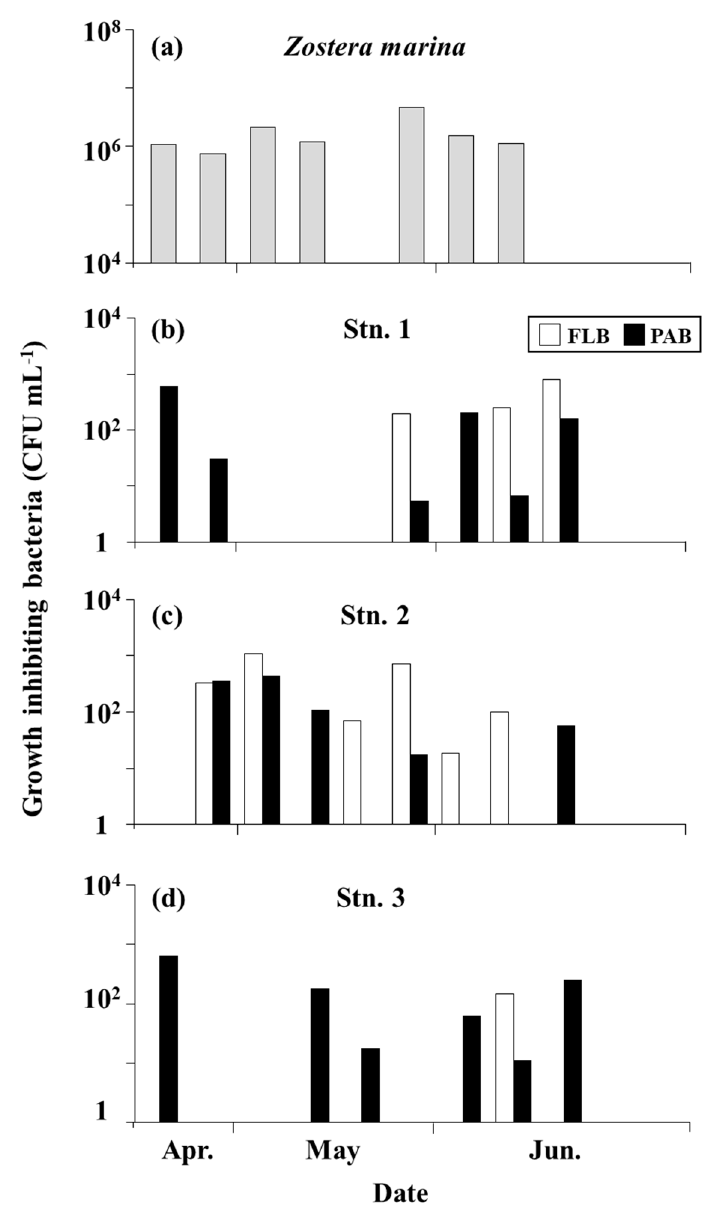
Figure 10. Temporal changes in the numbers of growth-inhibiting bacteria against Alexandrium catenella (Group I) detected from Zostera marina ( a ) and surface seawaters collected at Stn. 1 ( b ), Stn. 2 ( c ), and Stn. 3 ( d ). PAB: particle-associated bacteria (the >3 µm fraction: ■ ). FLB: free-living bacteria (the <3 µm fraction: □ ).